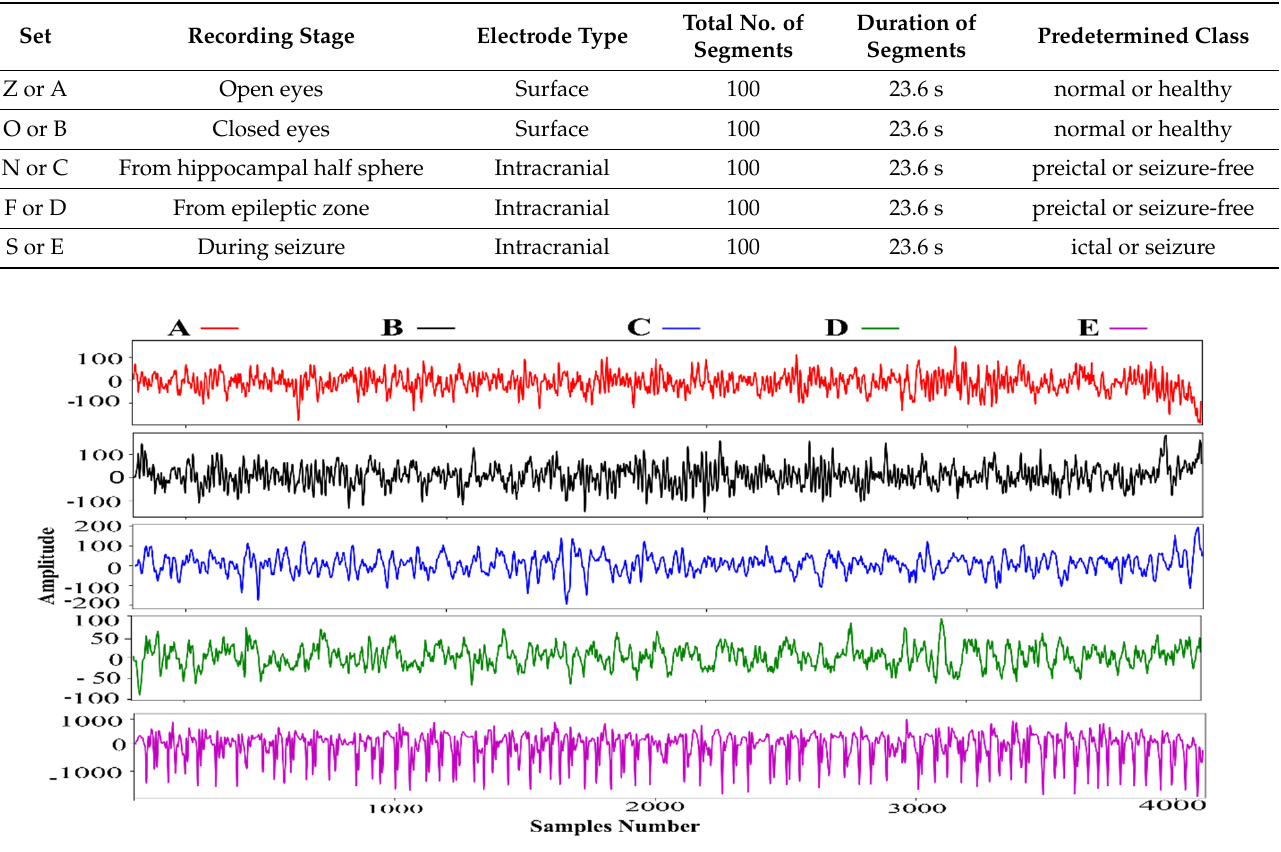
Table 1. Explanations of the dataset used in this study.